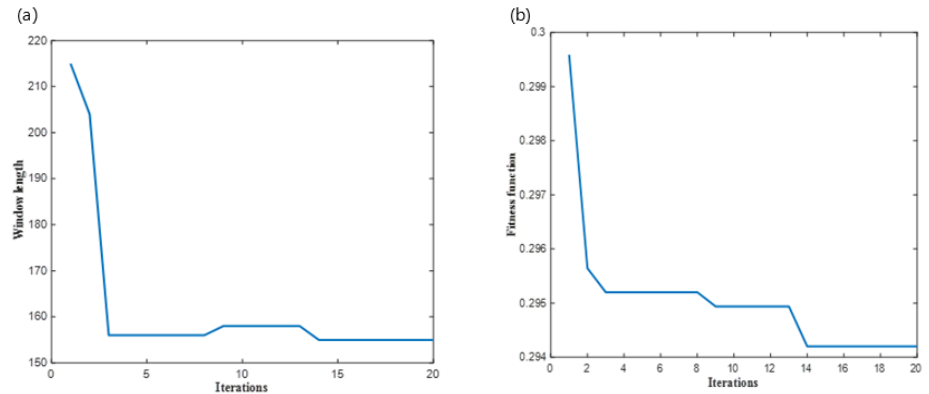
Figure 4. PSO optimization algorithm fitness curve. ( a ) Window length; ( b ) root mean square er- ror.